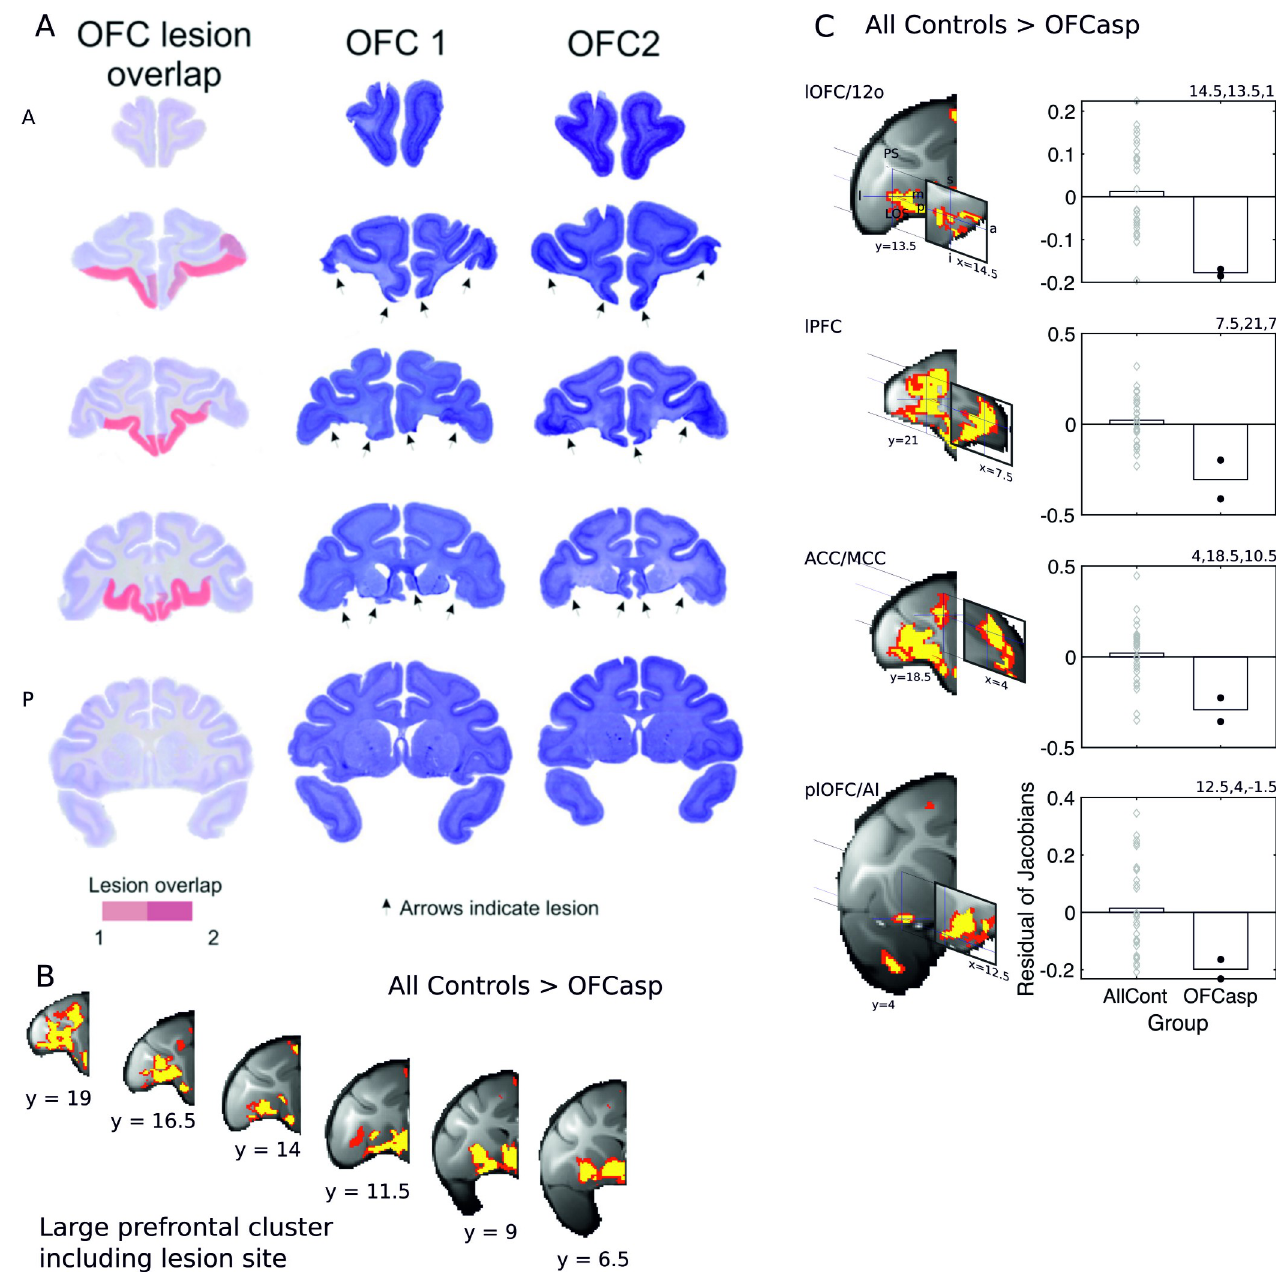
Fig 4. Lesions of central and medial OFC and adjacent vmPFC between the lateral orbital sulcus and the rostral sulcus. Panel A shows coronal sections through the frontal cortex (the most rostral section is shown at the top left, and the most caudal is shown on the bottom right). The lesions were intended to cover the same region investigated by Rudebeck and colleagues [3]. The actual lesion is indicated by red coloring. Saturated red color indicates area of lesion overlap in both animals, whereas paler red color indicates area of lesion in a single individual. Lesions were associated with large gray matter decrements in a distributed set of brain regions, including not only the aspiration lesion site itself (B) but also the four frontal regions associated with DisRev learning in experiment 1, including lOFC/12o (top row), lPFC on the ventral bank (second row), ACC/MCC, and plOFC/AI (C). In both panels B and C, the results illustrated are for bilaterally symmetrical effects ( p < 0.001) and are shown in yellow and red ( p < 0.005). Because in the initial stages of analysis, all scans from both before and after training are registered to a template derived from their average, the baseline residual Jacobian values in each figure lie close to the mean. 12o, orbital part of area 12; a, anterior; ACC/MCC, anterior cingulate cortex/midcingulate cortex; AllCont, all control; DisRev, discrimination reversal; l, lateral; lOFC, lateral OFC; lPFC, lateral prefrontal cortex; m, medial; OFC, orbitofrontal cortex; p, posterior; OFCasp, OFC aspiration lesion; plOFC, posterior lOFC; plOFC/AI, plOFC extending into AI; s, superior; vmPFC, ventromedial prefrontal cortex. Data are available on https://www.jeromesallet.org/data-ofc- reversal-learning and https://doi.org/10.5281/zenodo.3776631.